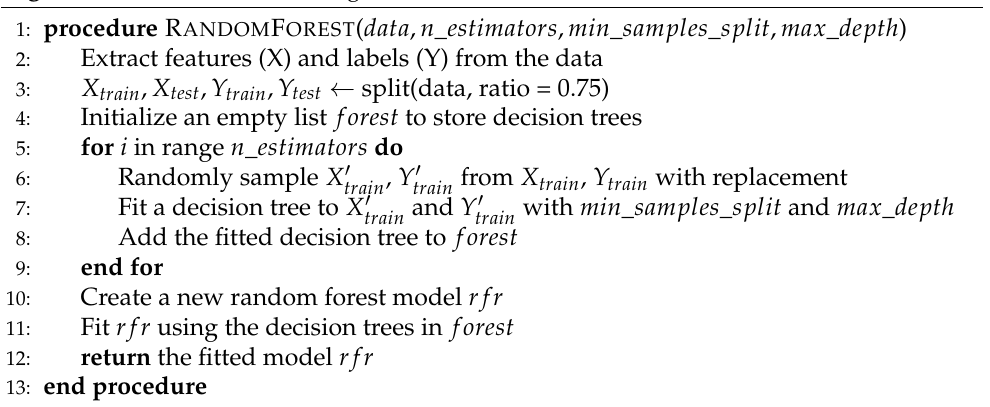
Algorithm 1 Random Forest Regression.